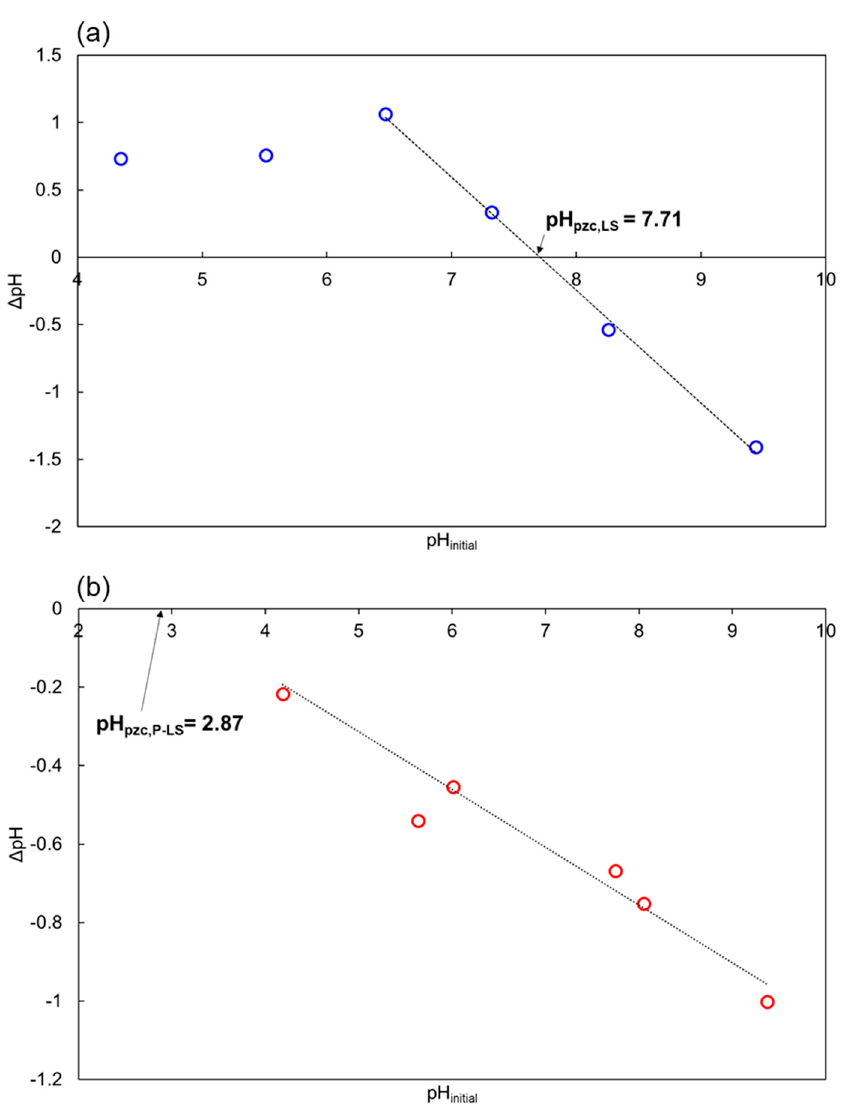
Figure 4. Point of zero charge of LS ( a ) and P − LS ( b ).